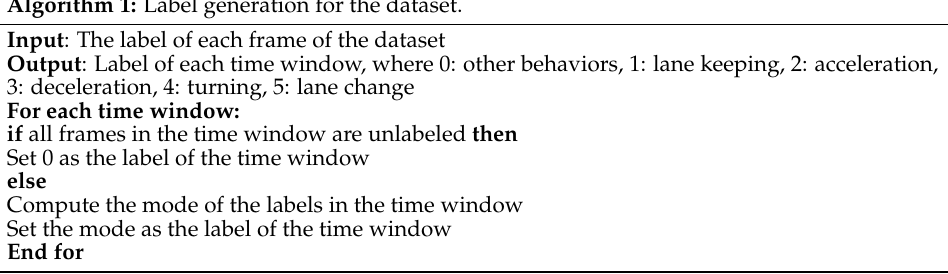
Algorithm 1: Label generation for the